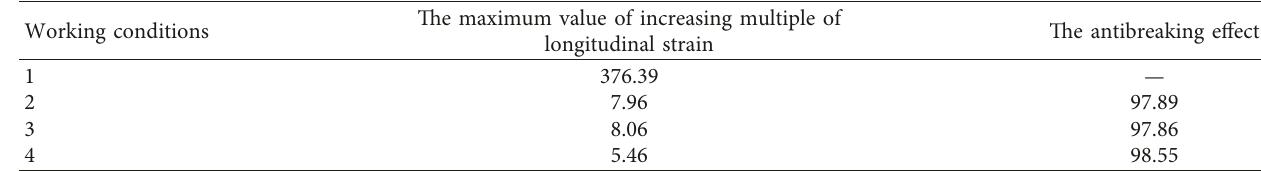
Table 6: Antibreaking effect of longitudinal